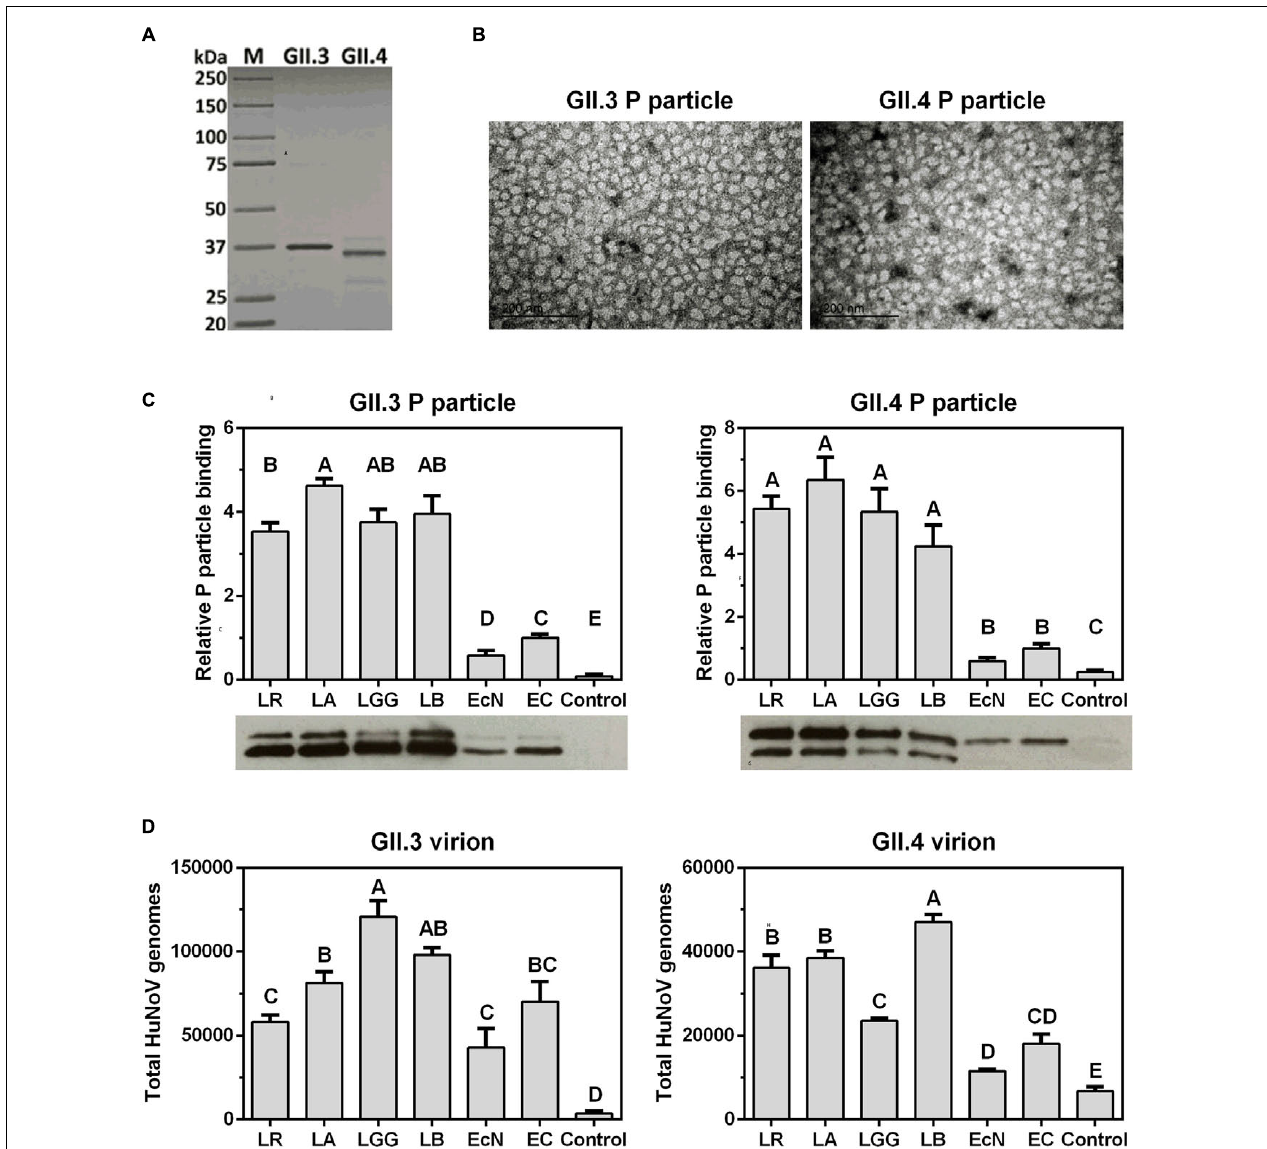
FIGURE 1 | Probiotic bacteria bind to HuNoV P particles and virions. (A) SDS-PAGE analysis of the 6 × His tagged P proteins expressed and purified from the prokaryotic system. Lane 1, protein standard marker. Lanes 2 and 3, GII.3 and GII.4 P proteins. (B) Transmission electron micrographs of P particles. Scale bar, 200 nm. (C) Probiotic bacteria bind to P particles. Bottom panels, representative Western Blot using anti-His-Tag antibody showing the P particles bound to bacteria. Top panels, four independent experiments were analyzed by Image J. The relative bindings are referred to that of EC. (D) Probiotic bacteria bind to virions. The virions bound to bacteria were quantified by qRT-PCR for viral genomes. The experiments were repeated three times independently. Controls were heat-killed and A&H antigen antibodies-blocked EC. Data are presented as mean ± SEM. Statistics was determined by one-way analysis of variance (ANOVA). Different letters indicate significant differences among groups ( P < 0.05), while shared letters indicate no significant